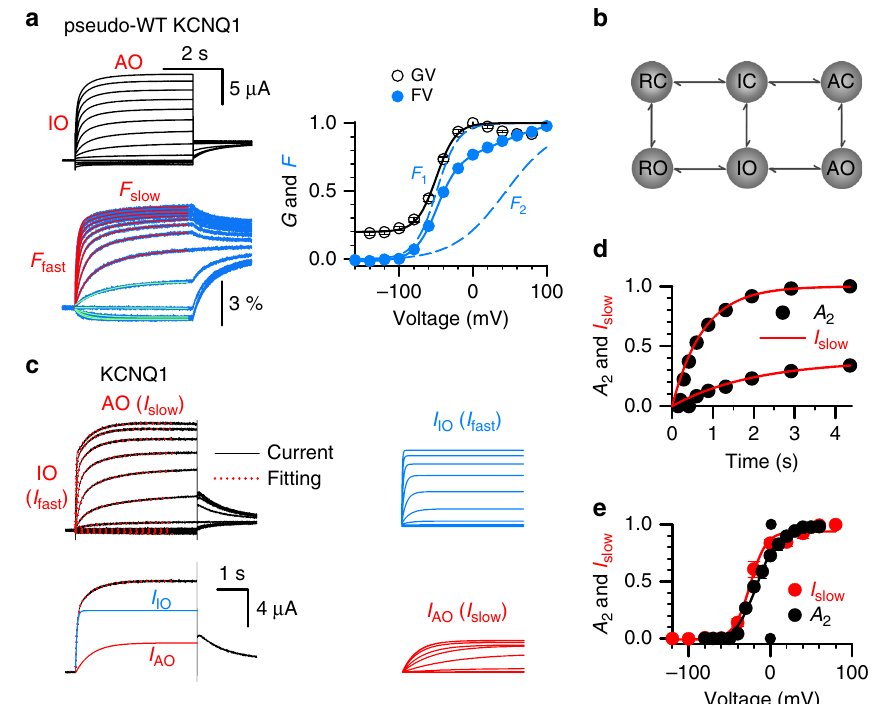
Fig. 2 Similar time and voltage dependence of hook currents and the AO state of the KCNQ1 channel. a VCF recordings of pseudo-WT (C214A/G219C/ C331A) KCNQ1 currents (black) and fl uorescence (blue), with voltages from − 140 – 100 mV in 20 mV increments and back to − 40 mV to test the tail currents. The fl uorescent traces were fi tted with a single (green) exponential equation below − 50 mV, and a double (red) exponential equation above − 50 mV showing both F fast and F slow components. Right panel, the G – V (black, V 50 = − 49.12 mV, slope = 13.81) and F – V (blue) relationships with F V = − 49.17 mV, slope = 14.67) and F V = 43.57 mV, slope = 38.00) components (dotted lines). b The scheme shows the two-step VSD 1 ( 50 2 ( 50 movements R ↔ I ↔ A and channel opening C ↔ O. c Upper left, the WT KCNQ1 currents (black lines) recorded with voltage ranging from − 120 – 80 mV were fi tted with a double exponential function (red dots). The tail currents were measured at − 40 mV. Lower left, the current (black line) recorded at 40 mV was fi t with a double exponential function (red dots). The blue trace is the fast component ( I fast ) representing the current of the IO state, and the red trace is the slow component ( I slow ) representing the current of the AO state. Right, I fast and I slow from the currents in upper left. d Dependence of A 2 on the pre-pulse duration (black, from Fig. 1e) and I slow on test pulse duration (red, from Fig. 2c) at − 20 and +40 mV. e The dependences of A 2 on pre-pulse voltages (black, from Fig. 1e) and I slow on test pulse voltages (red, from Fig. 2c) of KCNQ1 channels. The voltage for half activation ( V 1/2 ) of A 2 – V and I – V is − 18.2 ± 2.1 mV and − 25.0 ± 2.7 mV, respectively. n ≥ 4. Error bars are the SEM. RC resting closed, IC intermediate closed, AC activated slow